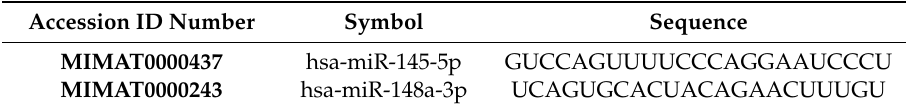
Table 2. miRNA accession numbers, symbols, and